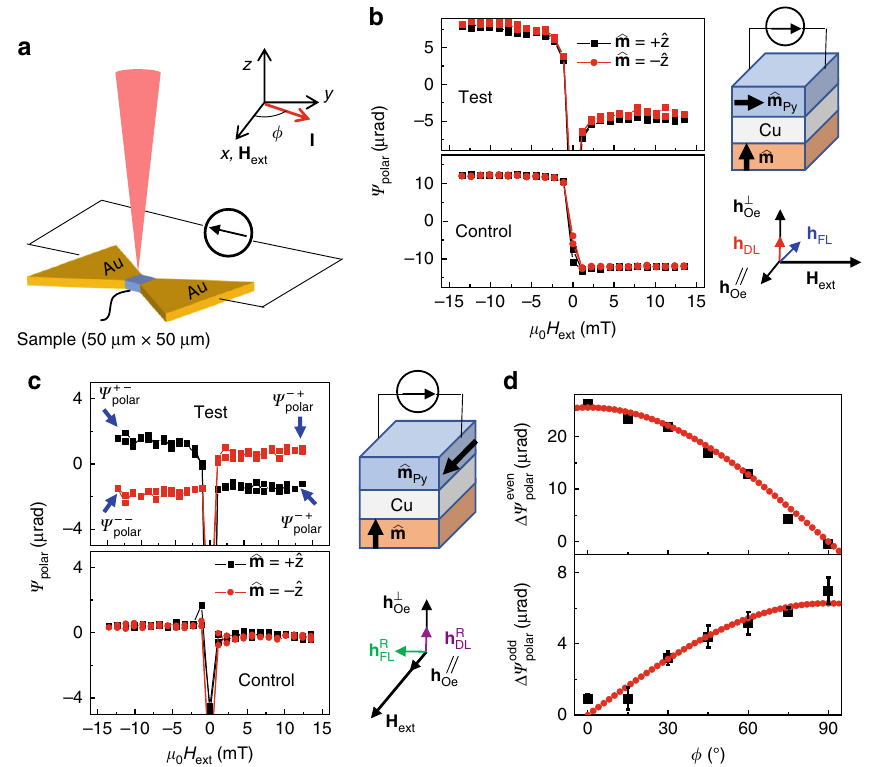
Fig. 2 Current-induced damping-like torque. a Experimental con fi guration for measuring the SOTs by MOKE magnetometry. b The polar MOKE response, ψ polar , measured in the test and control samples when current is applied parallel to geometry (for simplicity we omit the Pt capping and seed layers) and the effective fi elds applied on the sample are also shown. c The polar MOKE response measured in the test and control samples when current is applied perpendicular to H ext ( ϕ = 90°). In the test sample, the polar MOKE response is reversed when ^ m is reversed. In contrast, the polar MOKE response in the control sample has little dependence on ^ m . The weak hysteresis-like signal in the control sample is likely due to small misalignment ( ∼ 1.5°) of H ext . d The angle dependence of Δψ even the second superscript denotes the sign of ^ m Py . The red lines are fi ttings using Δψ even represent the standard deviation calculated from the linear fi tting in b used to calculate Δψ even